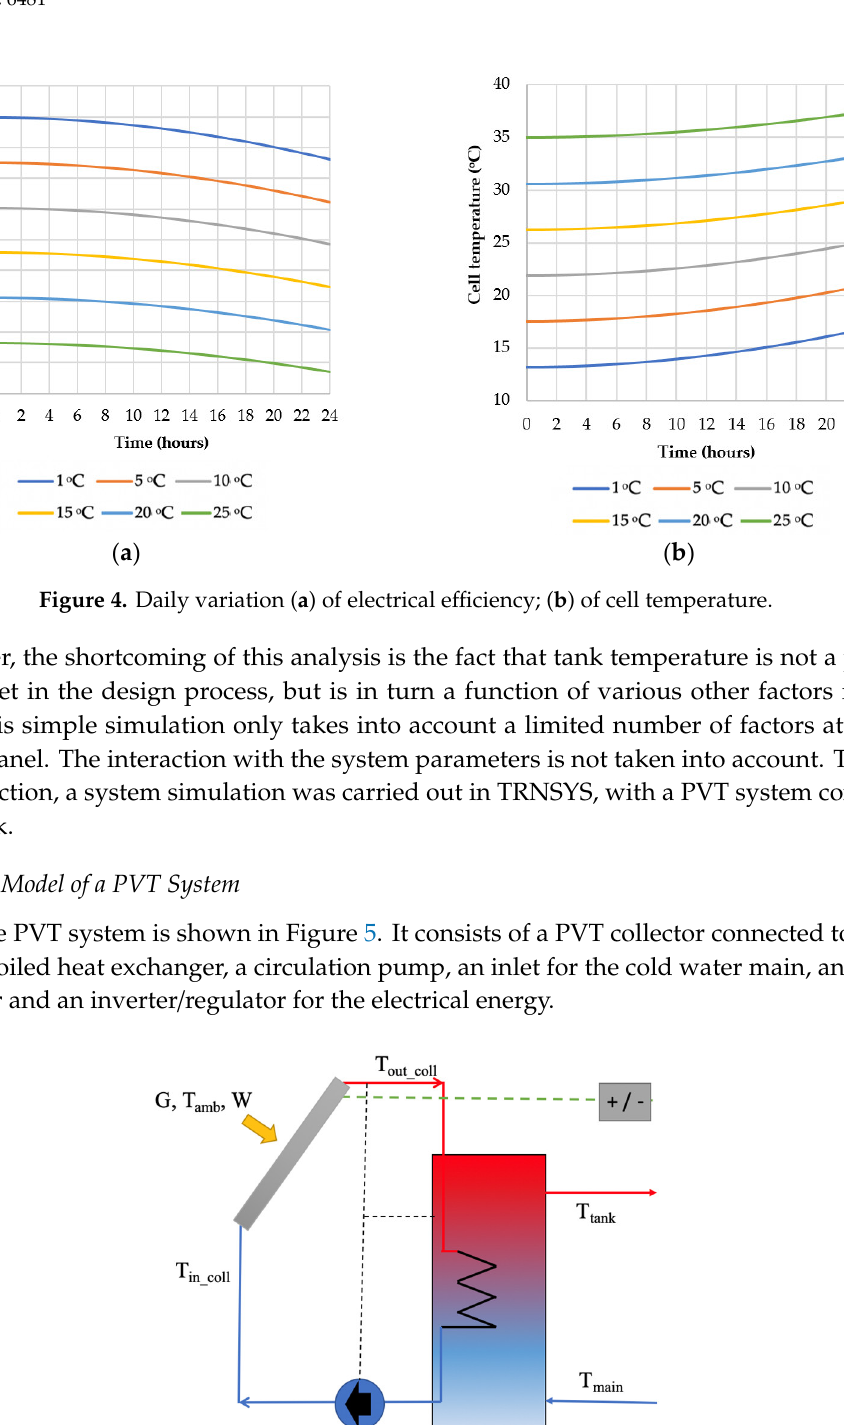
Figure 6. TRNSYS System. 2.3. Parametric Analysis The parametric analysis is performed according to the one factor at a time method (OFAT). The goal of this analysis is to identify the impact that each of the parameters has on the electrical efficiency of the panel. The ‘default’ parameters are listed in Table 1 below. The PVT area is equivalent to that of a system consisting of two PVT panels, assumed to be connected in series.